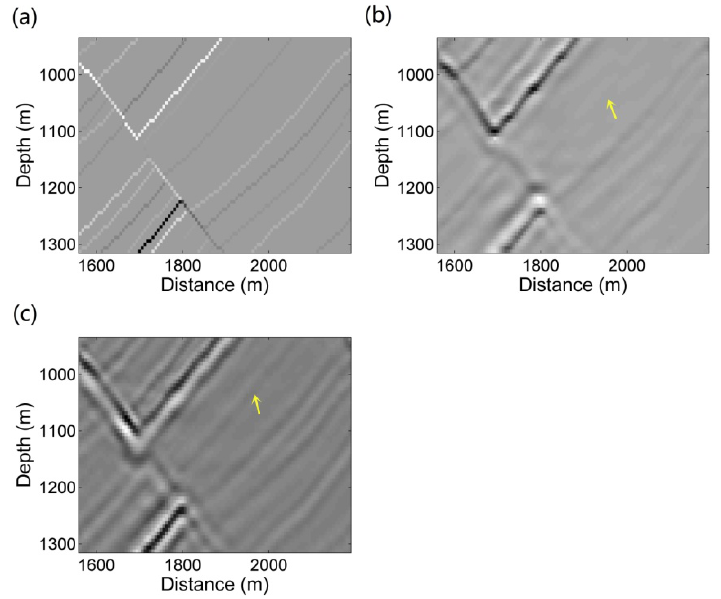
Figure 7. ( a ) The theoretical reflection coefficient; ( b ) The imaging result of RTM; ( c ) The imaging result of our proposed method.